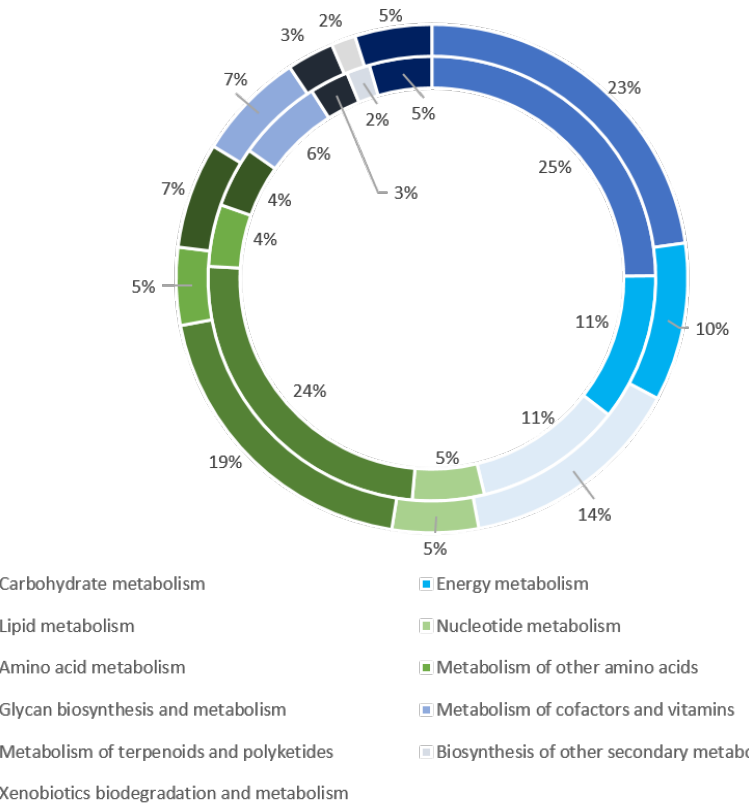
Figure 4. Representation of the W. magna transcripts and proteins related to metabolism. The transcripts and proteins are represented by the outer ring and inner ring, respectively.